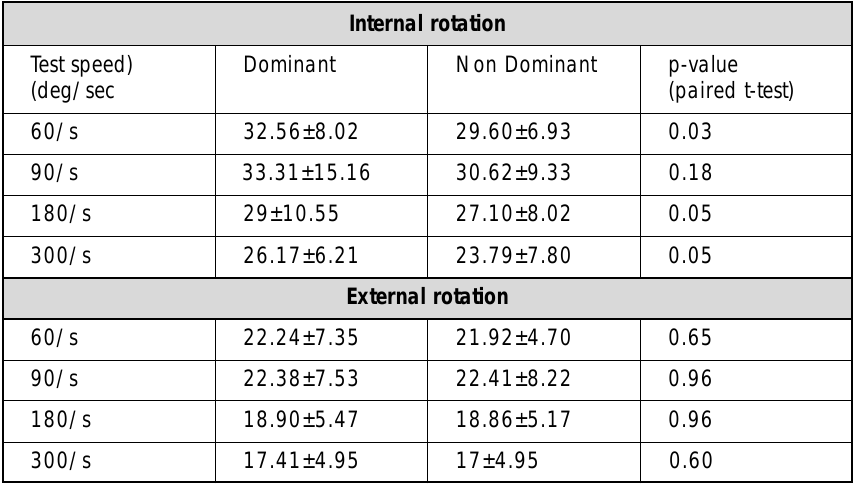
Table 4: Comparison of mean torque values between dominant and non-dominant bowling arms for shoulder internal and external rotation